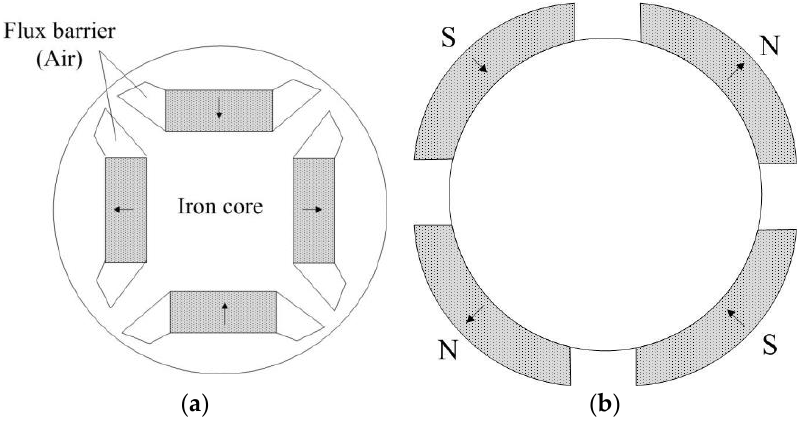
Figure 1. Permanent magnet synchronous motors (PMSM) rotor structures. ( a ) Embedded type; ( b ) Surfaced-mounted type.